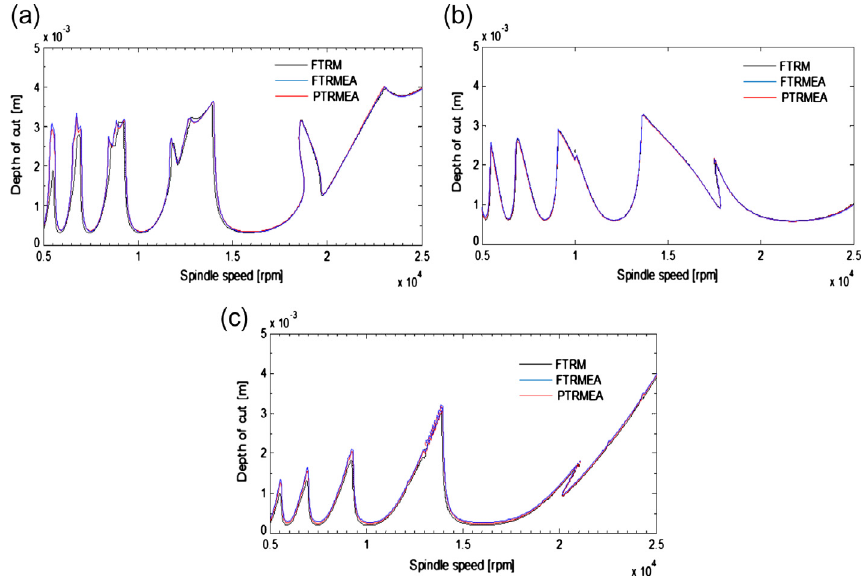
Figure 4. Stability lobes of (a) fully-immersed 1DOF milling process using FTRM (CT = 426 s), FTRMPA (CT = 434 s) and PTRMPA (CT = 417 s) placed on same axes to show that accuracy is marginally affected at low spindle speed, (b) half-immersed 1DOF down-milling process using FTRM (CT = 433 s), FTRMPA (CT = 408 s) (c) PTRMPA (CT = 397 s) placed on same axes to reveal that PA is accurate relative to FTRM, (c) half-immersed 1DOF up-milling process using FTRM (CT = 439 s), FTRMPA (CT = 404 s), PTRMPA (CT = 395 s) placed on same axes to reveal good accuracy of PA.